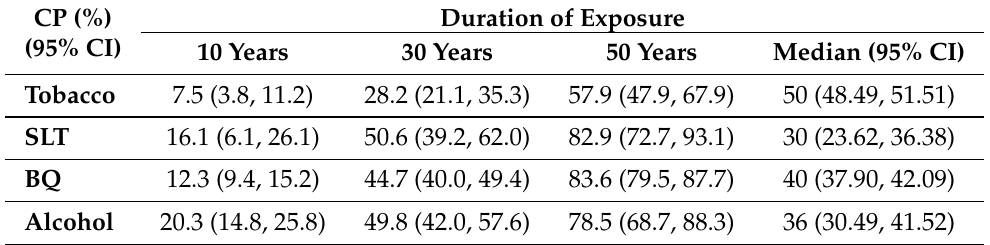
Table 6. Rates of OPMD occurrence with 10, 30, and 50 years of risk factor